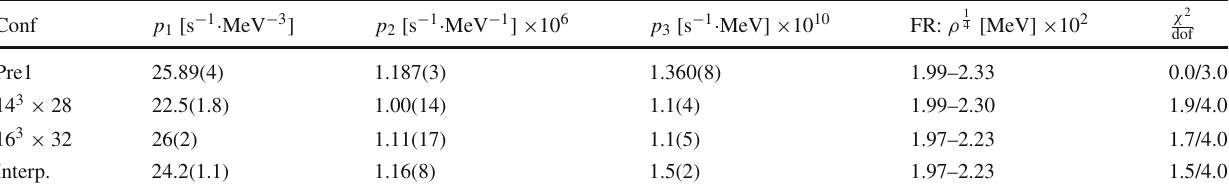
Table 26 The fitting results of the partial decay width (cid:15) by the curve (cid:15) = p 1 x 3 − p 2 x + p 3 of the prediction (cid:15) Pre1